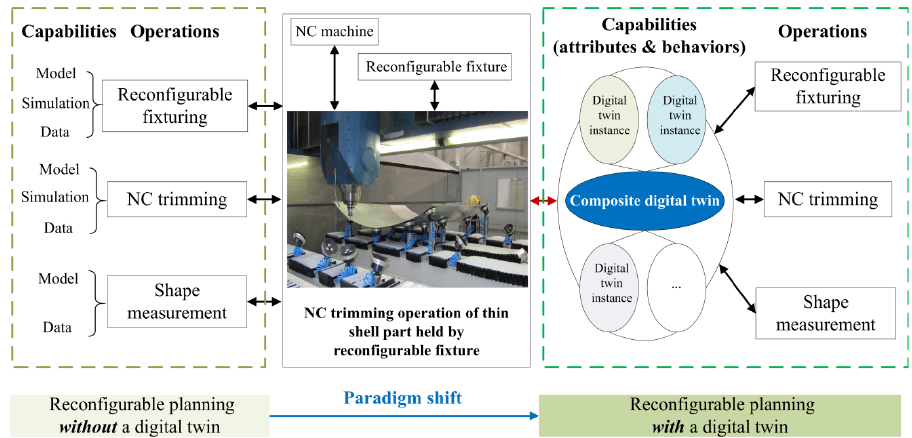
Figure 1. Digital twin-driven paradigm of reconfiguration planning.